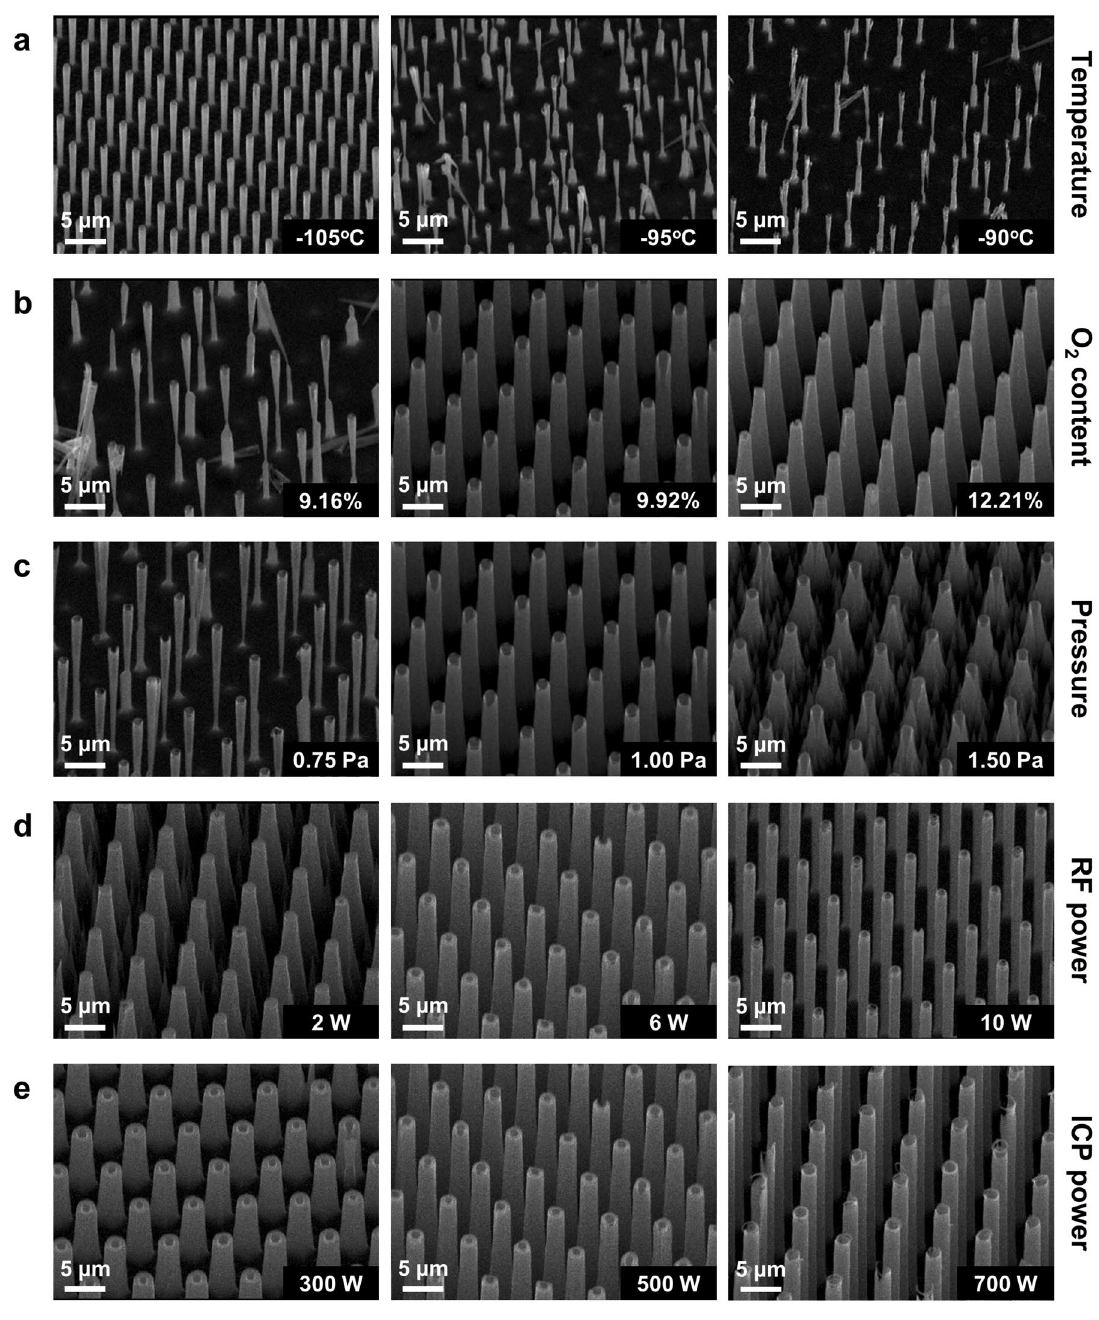
Figure 3. Vertical Si nanowire arrays fabricated by cryogenic ICP-RIE with different process parameters. The resulting Si nanowire profiles are affected by changing ( a ) temperature, ( b ) oxygen content, ( c ) pressure, ( d ) RF power, and ( e ) ICP power. Each of those parameters was varied while keeping the other parameters constant at the default parameter (see “Methods”). The increase in temperature, oxygen content, and pressure, respectively, led to more positively-inclined sidewalls. On the contrary, the rises of RF and ICP powers could remove the positive sidewalls yielding higher